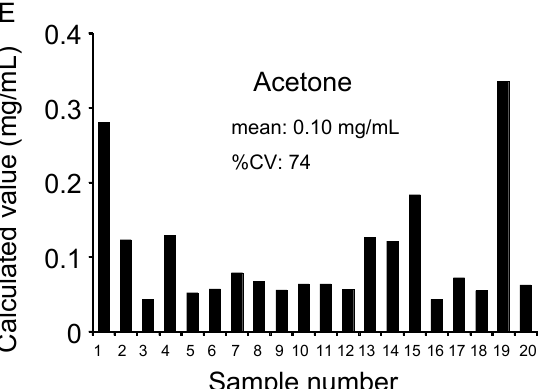
Figure 6. Comparison of albumin concentrations quantified by various methods. ( A ) Urine sample was quantified by an immunoturbidimetric assay. ( B ) Urine samples and albumin purified by ( C ) ammonium sulfate precipitation, ( D ) polyethylene glycol (PEG) precipitation, and ( E ) acetone precipitation were reacted with luciferin, and albumin concentration was calculated based on luminescence. The horizontal axis represents the sample number, and the vertical axis represents the calculated albumin concentration.